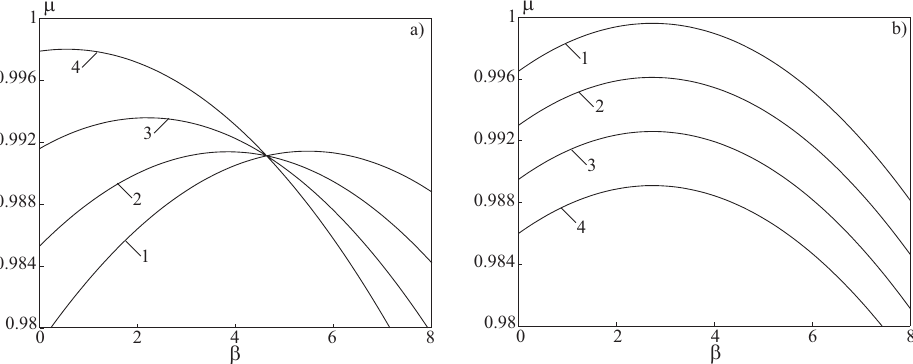
Figure 24. Dependance of rate coefficient on angle of nozzle rotation for k G = 0.15 ( a ) and ε = 0.5 ( b